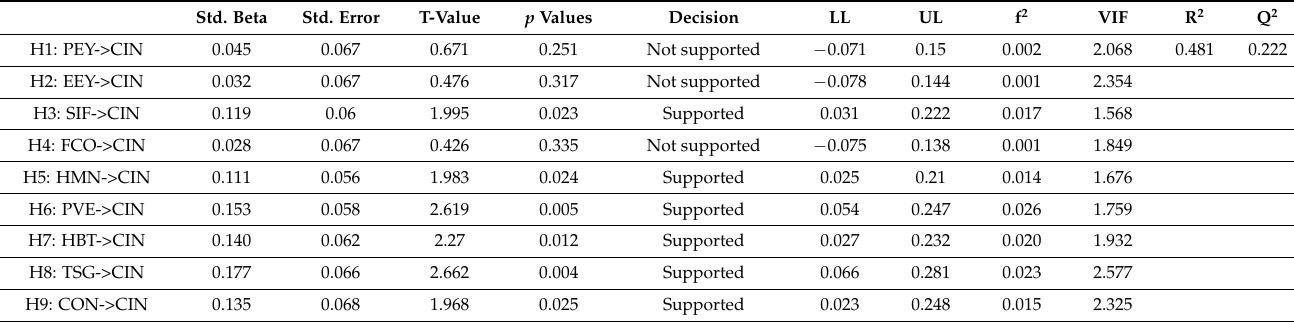
Table 4. Structural